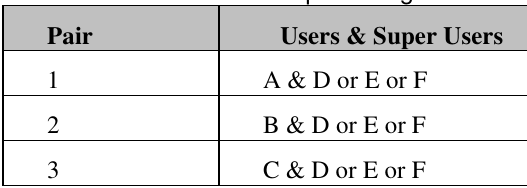
Table 1: Basic pair